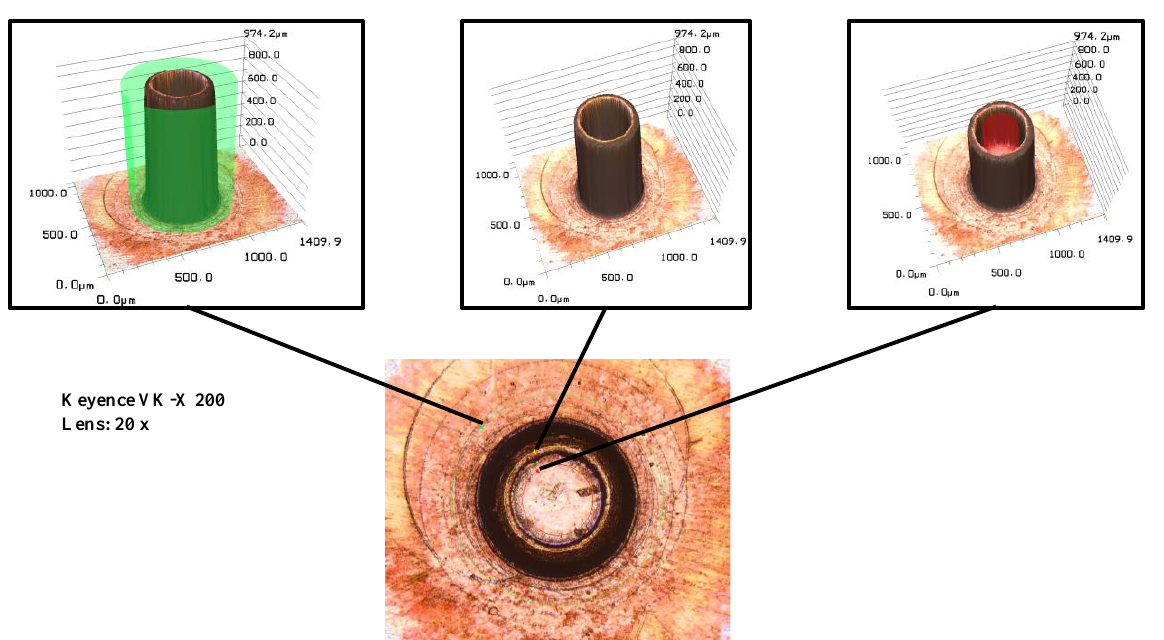
Figure 2. Strategy for measuring the micro parts by using a confocal laser scanning microscope.